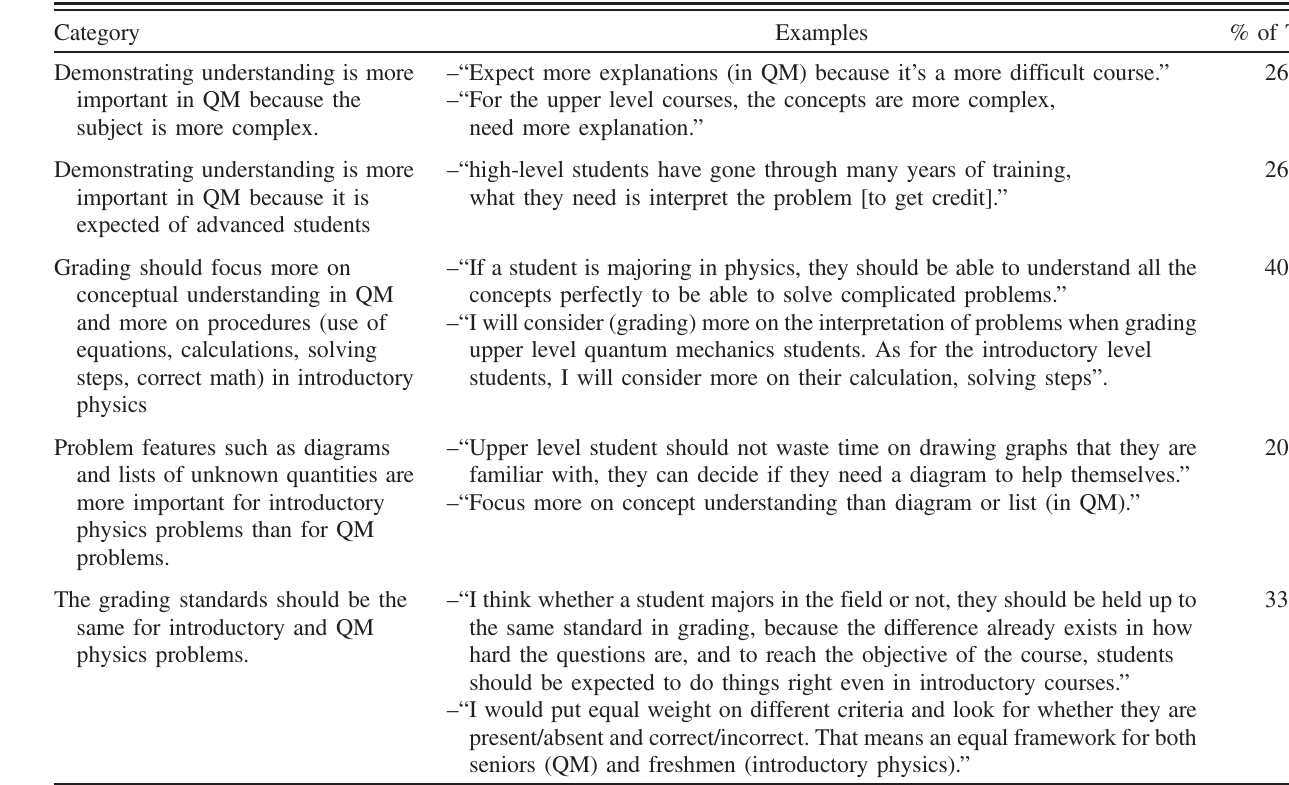
TABLE IV. Explanation of categories used for coding 15 TAs ’ stated differences or similarities when grading student solutions for introductory versus QM physics problems and percentages of TAs mentioning each category. TAs could mention more than one category so the percentages do not add up to